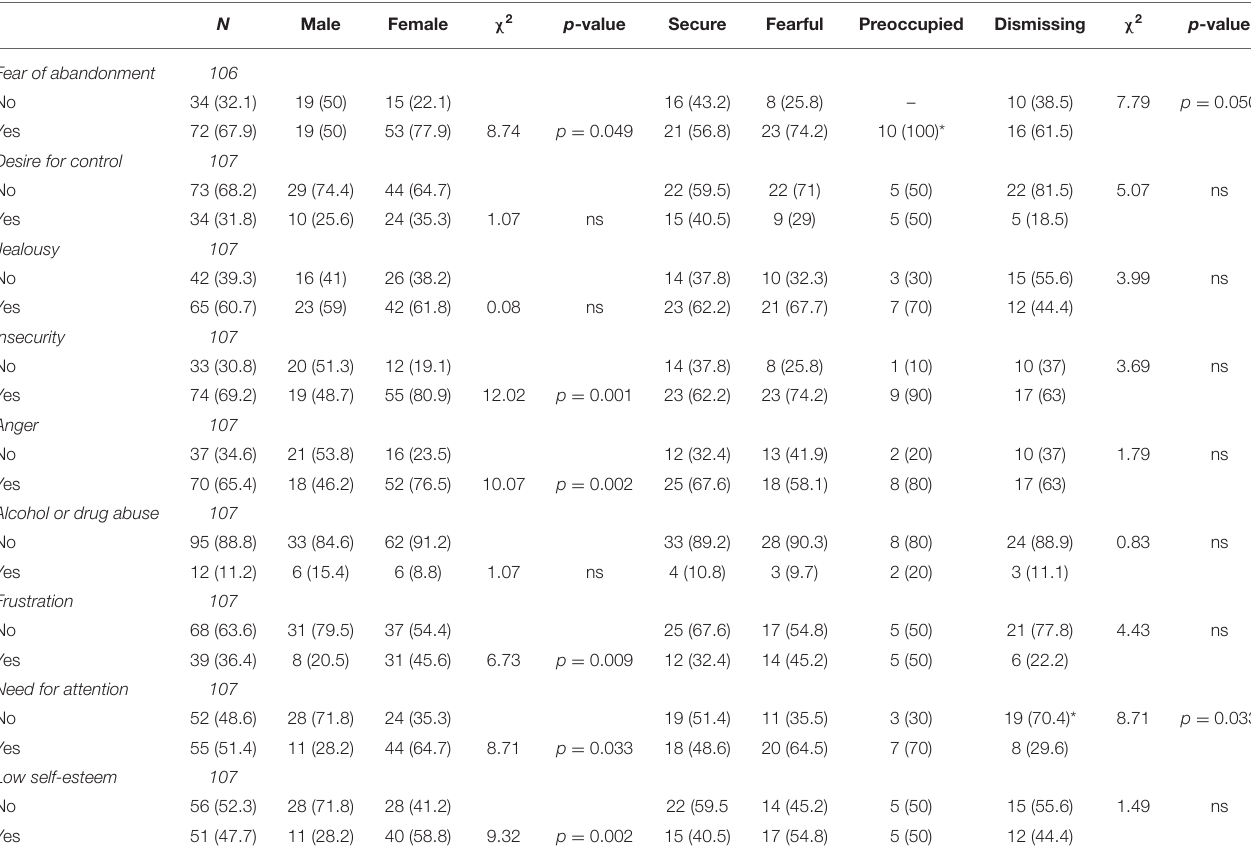
TABLE 4 | Cross-tabulation of gender and state of mind and motivations. N Male Female χ 2 p -value Secure Fearful Preoccupied χ